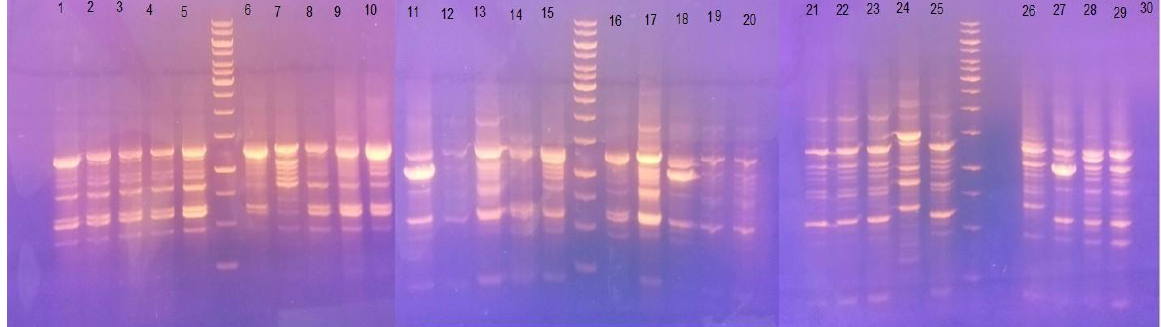
Figure 3. Agarose gel electrophoresis showing banding patterns of the 30 K. pneumoniae isolates by Random Amplified Polymorphic DNA (RAPD) typing method in comparison with the bands of a DNA ladder (ThermoscientificTM O'GeneRuler 1 kb Plus). Lane numbers indicate the code of the tested isolates.